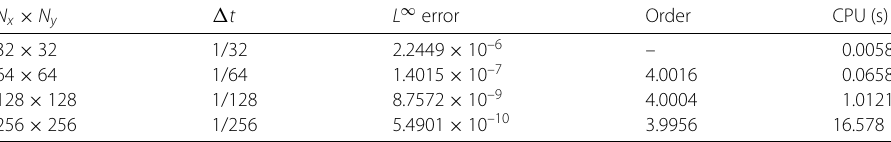
Table 2 Error, order of accuracy, and CPU time with DC4 scheme for Example 1 N x × N y